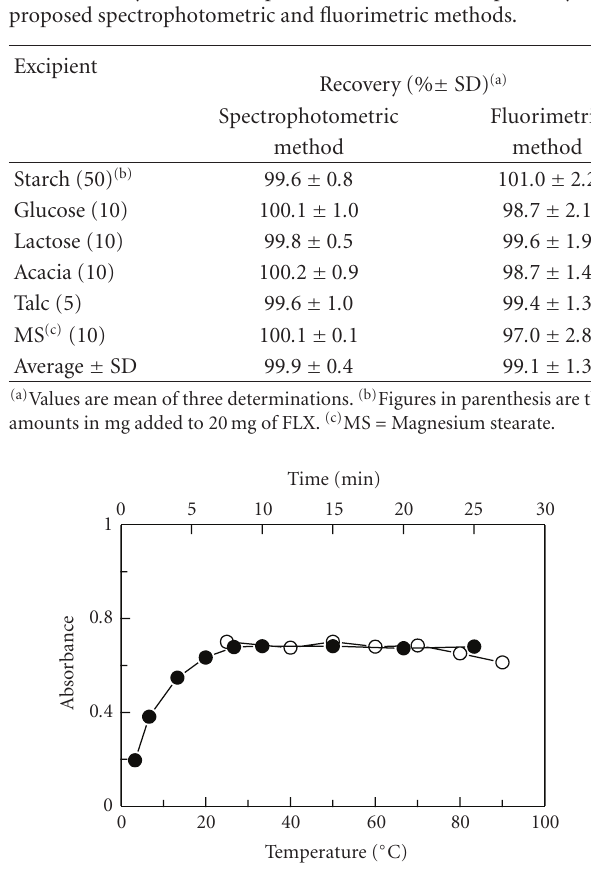
Figure 5: E ff ect of temperature ( • ) and time ( ◦ ) on the reaction of FLX (3 μ g mL − 1 ) with NQS (0.5%, w/v).